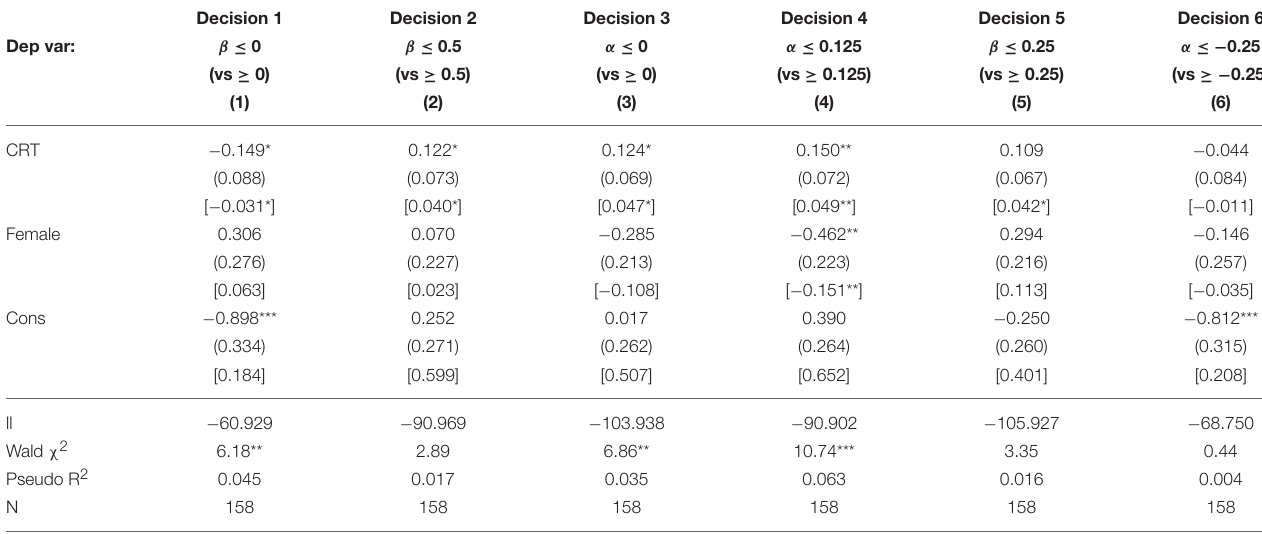
TABLE 4 | Non-egalitarian choice (option B) as a function of CRT (Study 2). Decision 1